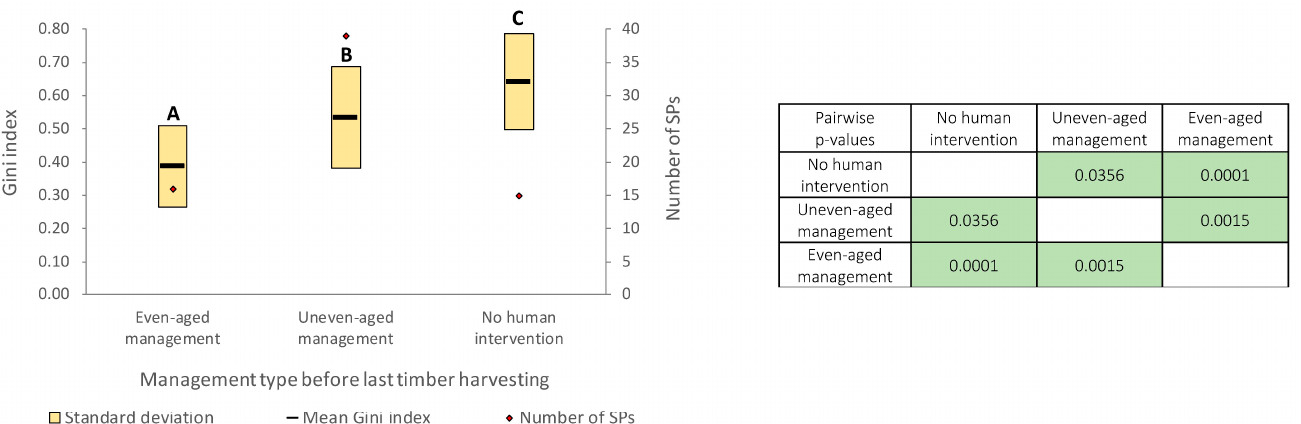
Figure 3. Forest structure diversity on forest management types (green color highlights the significant differences: p < 0.05). A,B,C—different letters indicate significant differences.